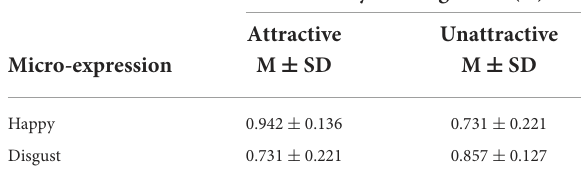
TABLE 2 Mean accuracy of recognition of each Micro-expression in Experience